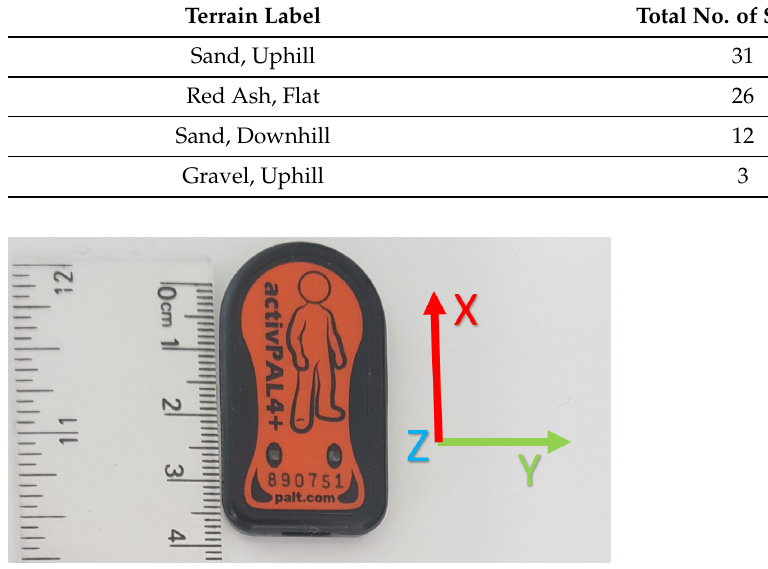
Figure 1. Scaled diagram of an ActivPAL device, with axes of orientation for reference.